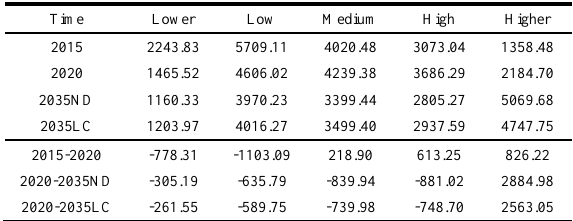
Table 7. Area and change of each level of landscape ecological risk.